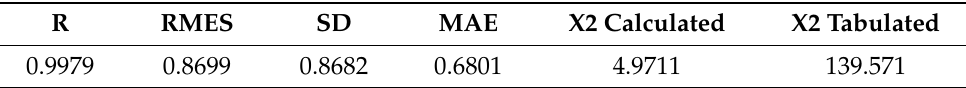
Table 8. Outputs of the best ANN